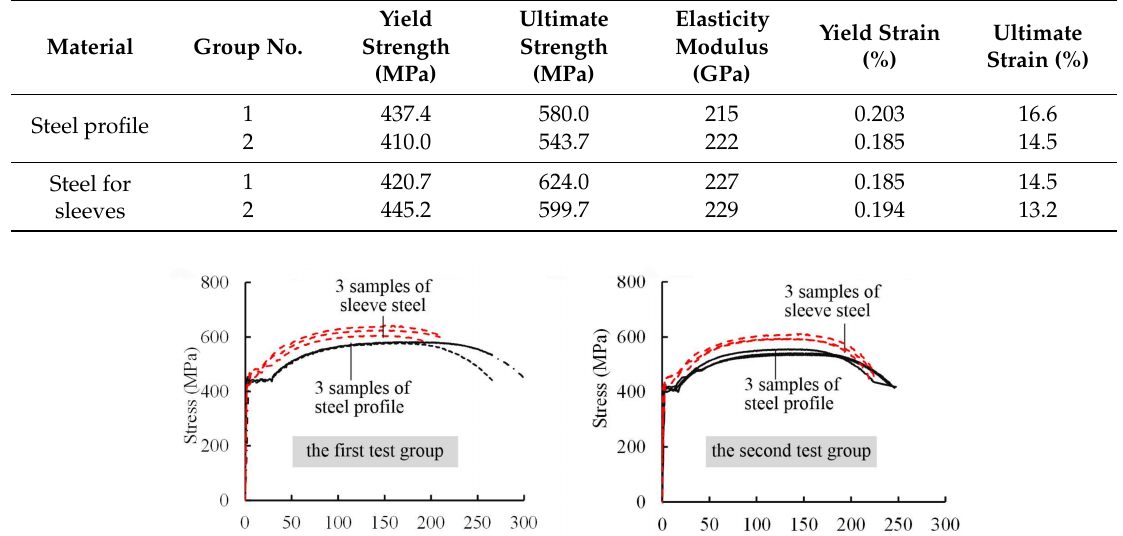
Table 2. Material properties for steel profile and sleeve steel [21].